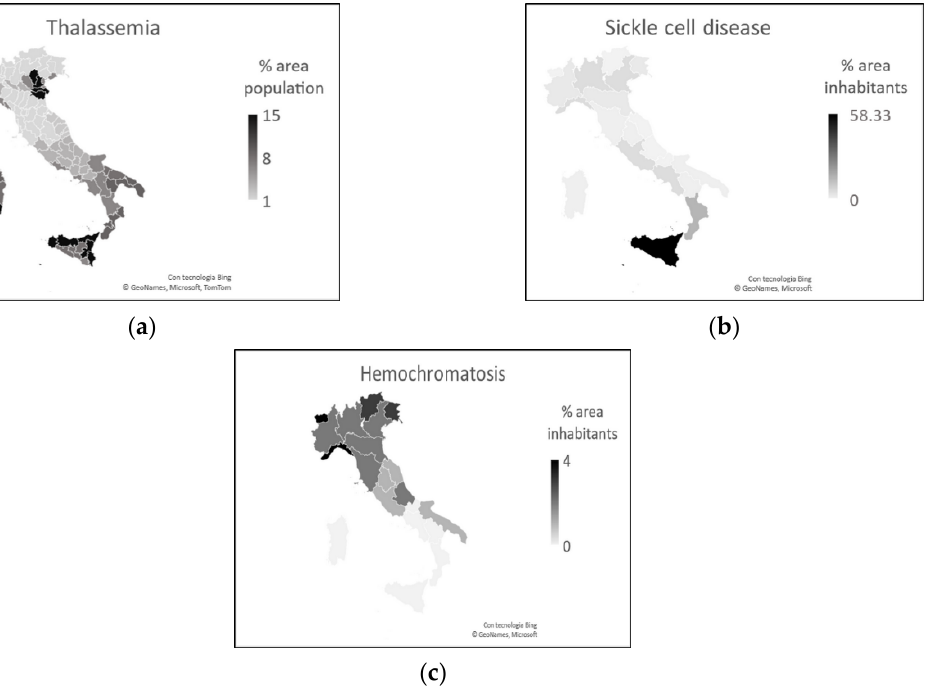
Figure 6. ( a ) Thalassemia distribution. ( b ) Anemia distribution. ( c ) Hemochromatosis distribution. Hemochromatosis and other iron overload diseases are more common in the north than in southern Italy. In particular, the spread of these diseases decreases from north to south [20–27].